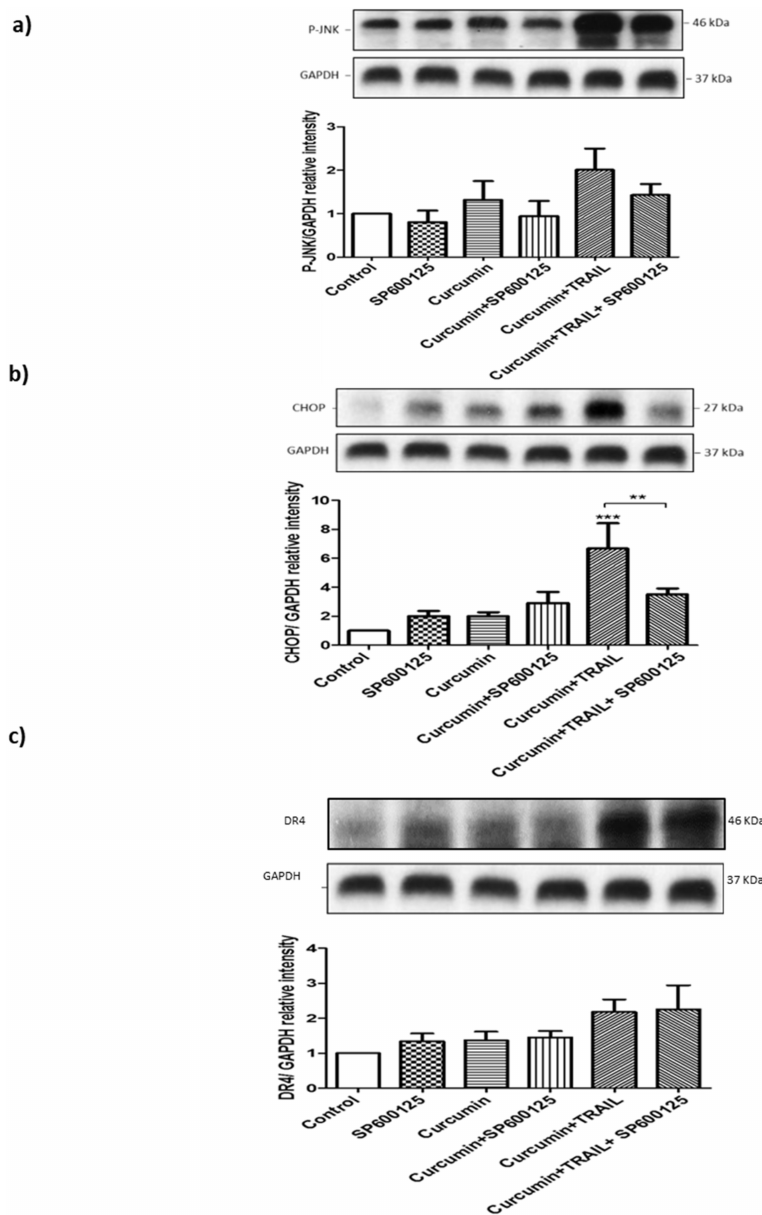
Figure 12. CHOP, but not DR4, was activated by JNK following curcumin / TRAIL combination treatment ACHN cells were either pre-treated with DMSO or 10 µ M JNK inhibitor (SP600125) for 1 h. Cells were then treated with vehicle control, 50 ng / mL TRAIL, 25 µ M curcumin or 50 ng TRAIL / 25 µ M curcumin. Whole cell protein was extracted at 24 h with RIPA bu ff er. Equal amounts of protein were separated by SDS-PAGE electrophoresis, transferred to nitrocellulose and indirectly probed for ( a ) P-JNK, ( b ) CHOP and ( c ) DR4 using a mAb and ECL detection system. GAPDH was used as a loading control. Representative blots are shown from 3 independent experiments. ** = p < 0.01 and *** = p < 0.001. One-way ANOVA was used to analyse the